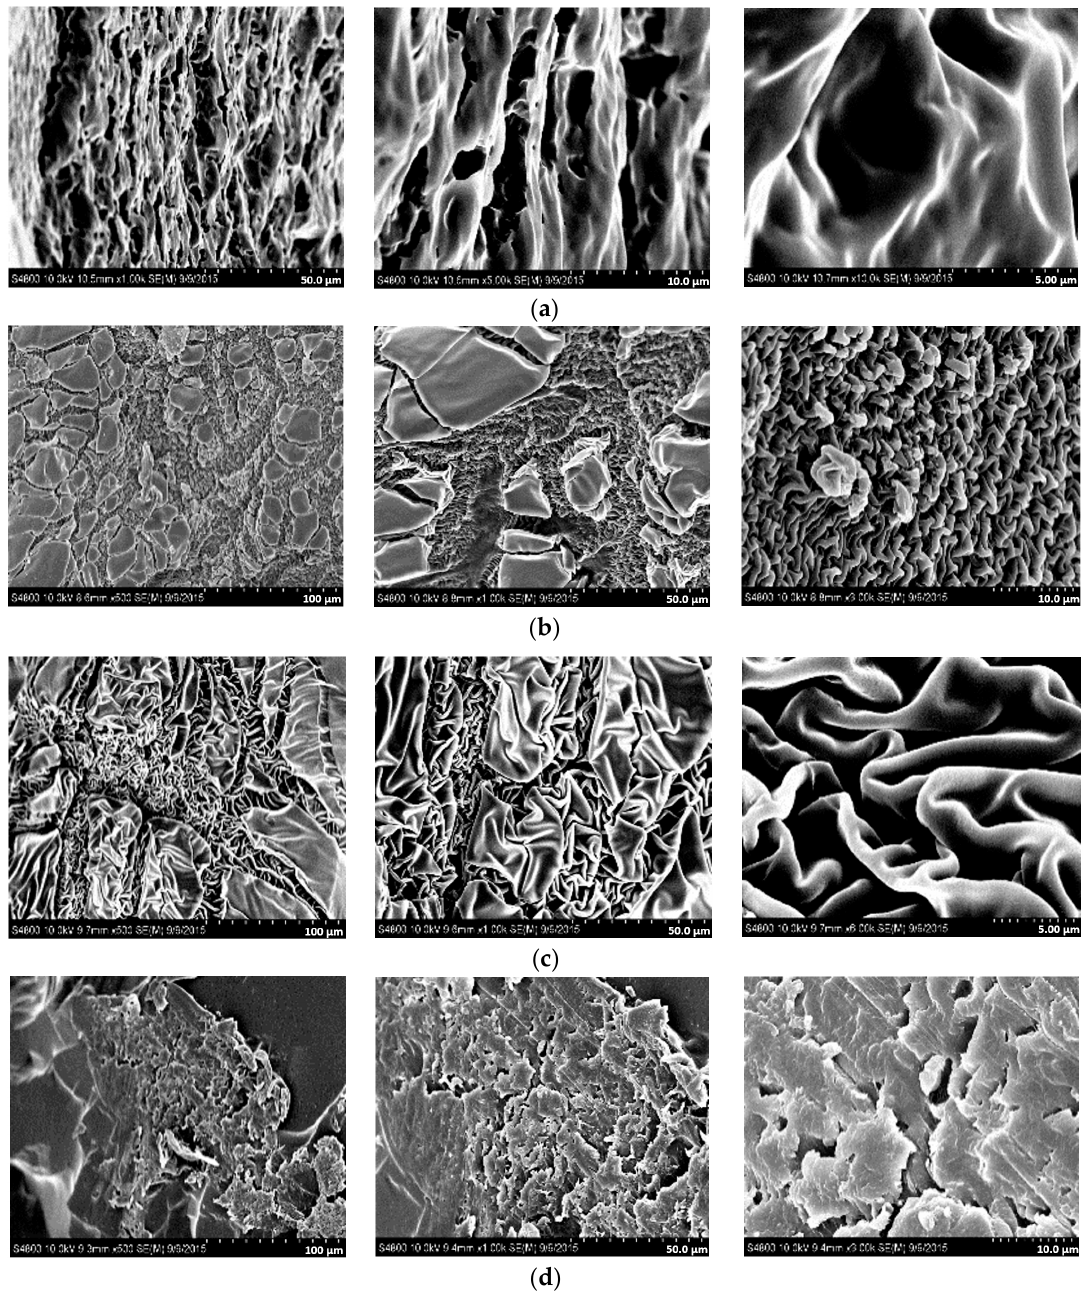
Figure 9. Scanning electron microscopic (SEM) images of: ( a ) CDg-0; ( b ) CDg-1.7; ( c ) CDg-2.5; and ( d ) CDg-5.